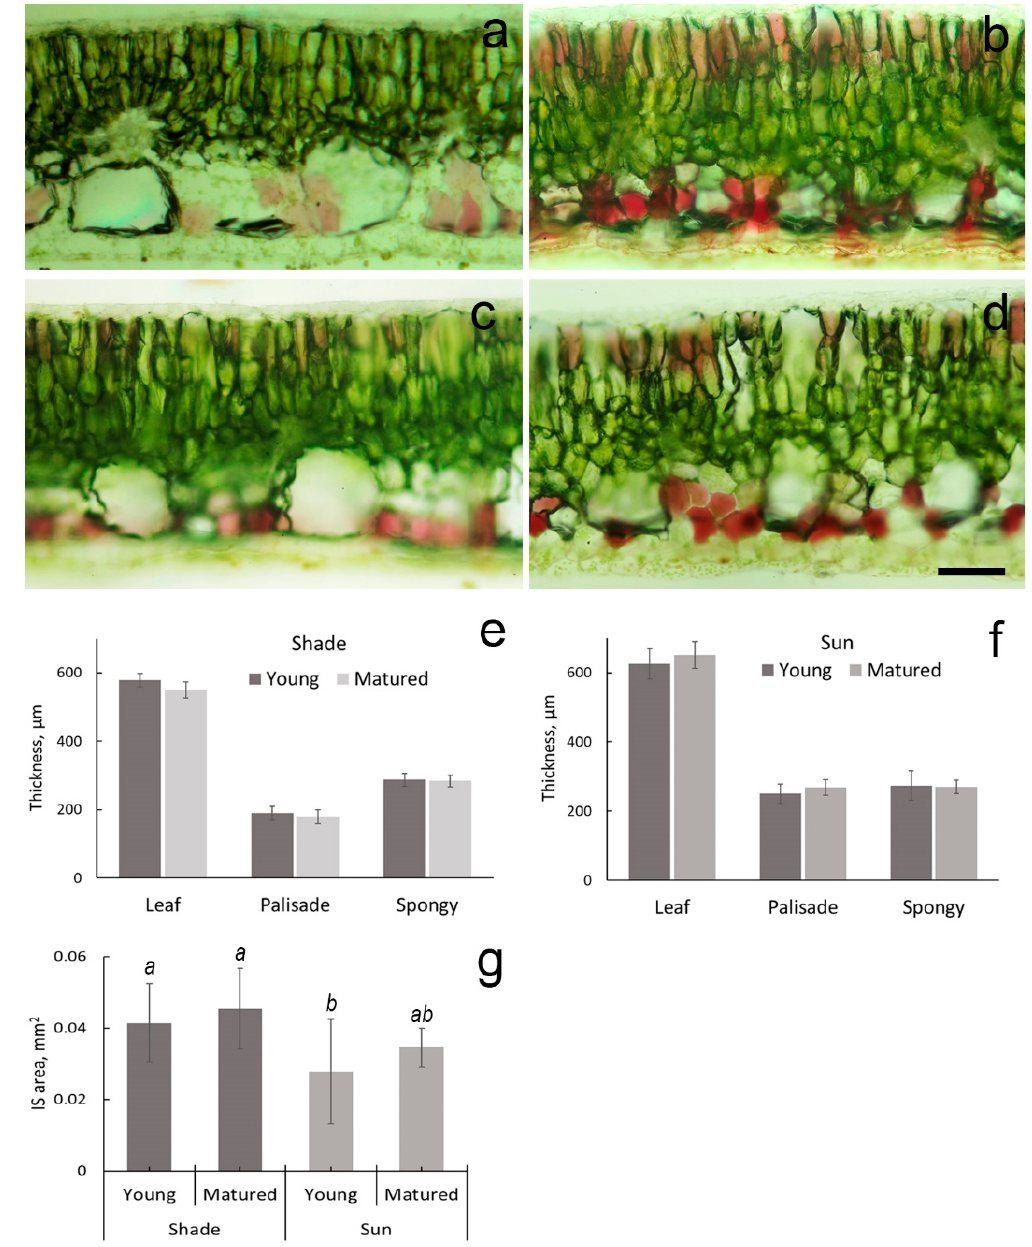
Figure 2. Hand-made cross-sections of Hydrocharis morsus-ranae young ( a , b ) and mature ( c , d ) leaves in the shade ( a , c ) and in the sun ( b , d ) without staining. Anthocyanin spots are seen in cells of the subepidermal layer of adaxial and abaxial leaf surfaces. Histograms of a leaf blade, palisade and spongy parenchyma thickness ( e , f ) and area of intercellular spaces (IS) in the spongy parenchyma ( g ). Different letters on Figure 2g indicate significant difference in IS area (one-way ANOVA, p < 0.05). Scale bar—100 µ